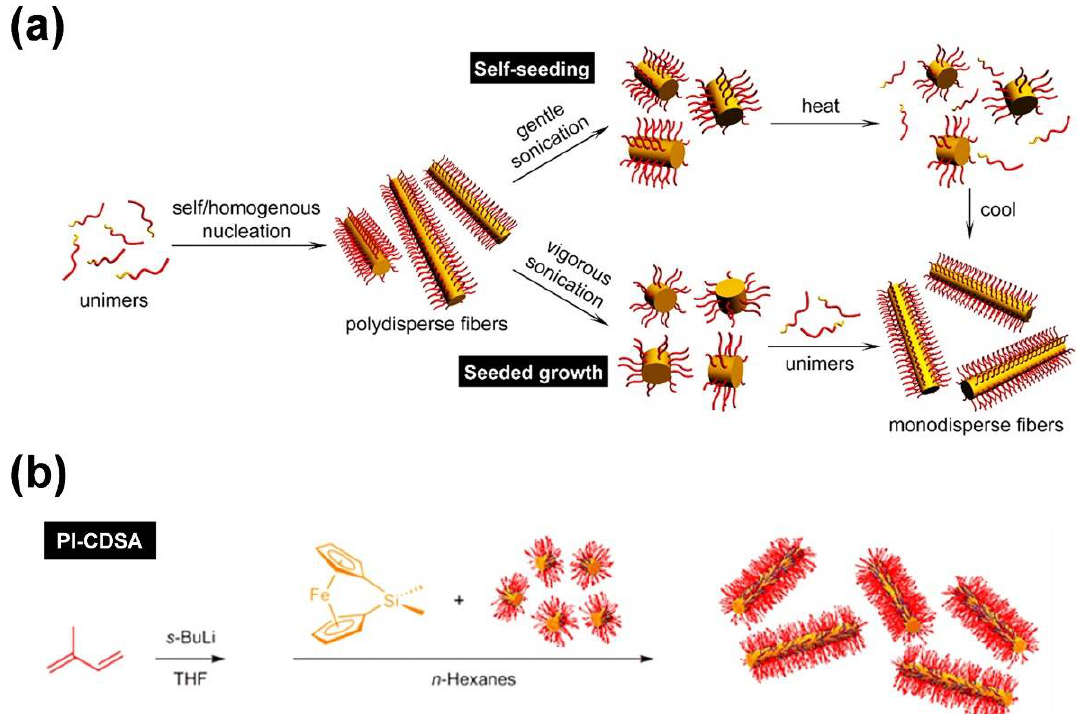
Figure 2. ( a ) Concepts for living CDSA, enabling the production of cylindrical micelles with defined length and narrow length distribution. Self-seeding employing seeds produced by thermal treatment of micelle fragments (top) and seeded growth using small micellar fragments (“stub”-like micelles) as seeds (bottom). ( b ) Living polymerization-induced CDSA (PI-CDSA) utilizing micellar seeds during anionic polymerization of the PFS block. After complete conversion, the reaction was quenched with 4- tert -butylphenol. ( a ) Reproduced from [76] with permission of the American Chemical Society (ACS).